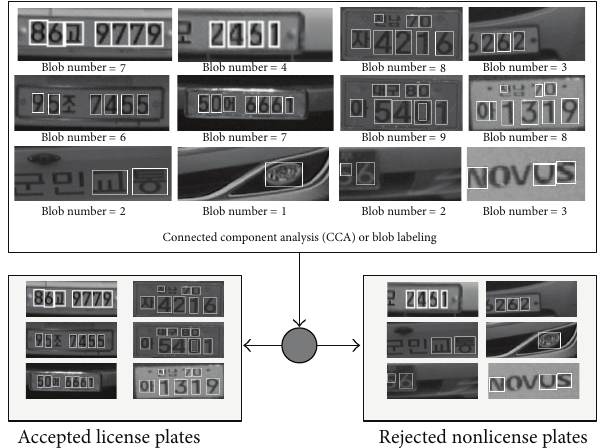
Figure 17: LPD results using adaptive